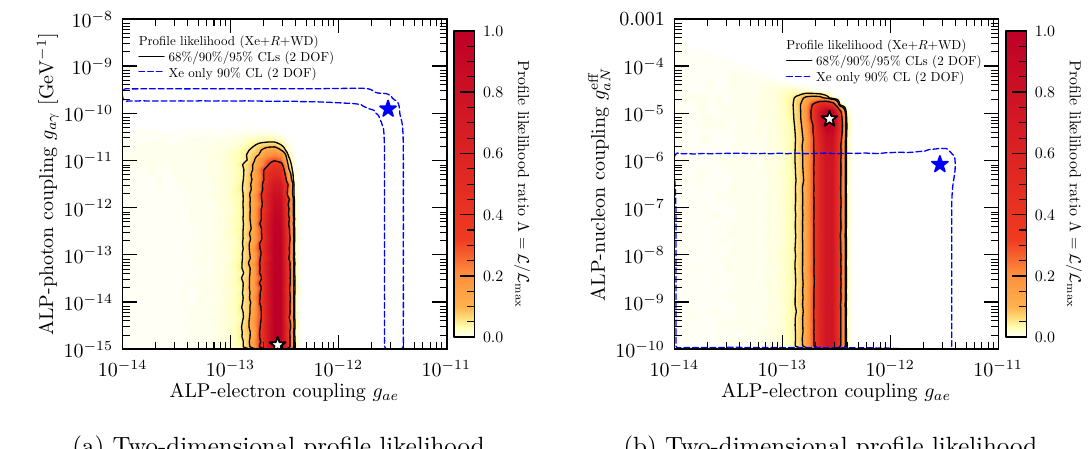
(a) Two-dimensional profile likelihood. (b) Two-dimensional profile likelihood. Figure 3. Profile likelihoods of solar ALP models for Xe + R + WD data for (a) the ALP-electron vs ALP-photon coupling and (b) the ALP-electron vs ALP-nucleon coupling. Blue dashed lines show the 90% CL limit from Xe data only. White (blue) stars denote the combined (Xe data only) best-fit point.